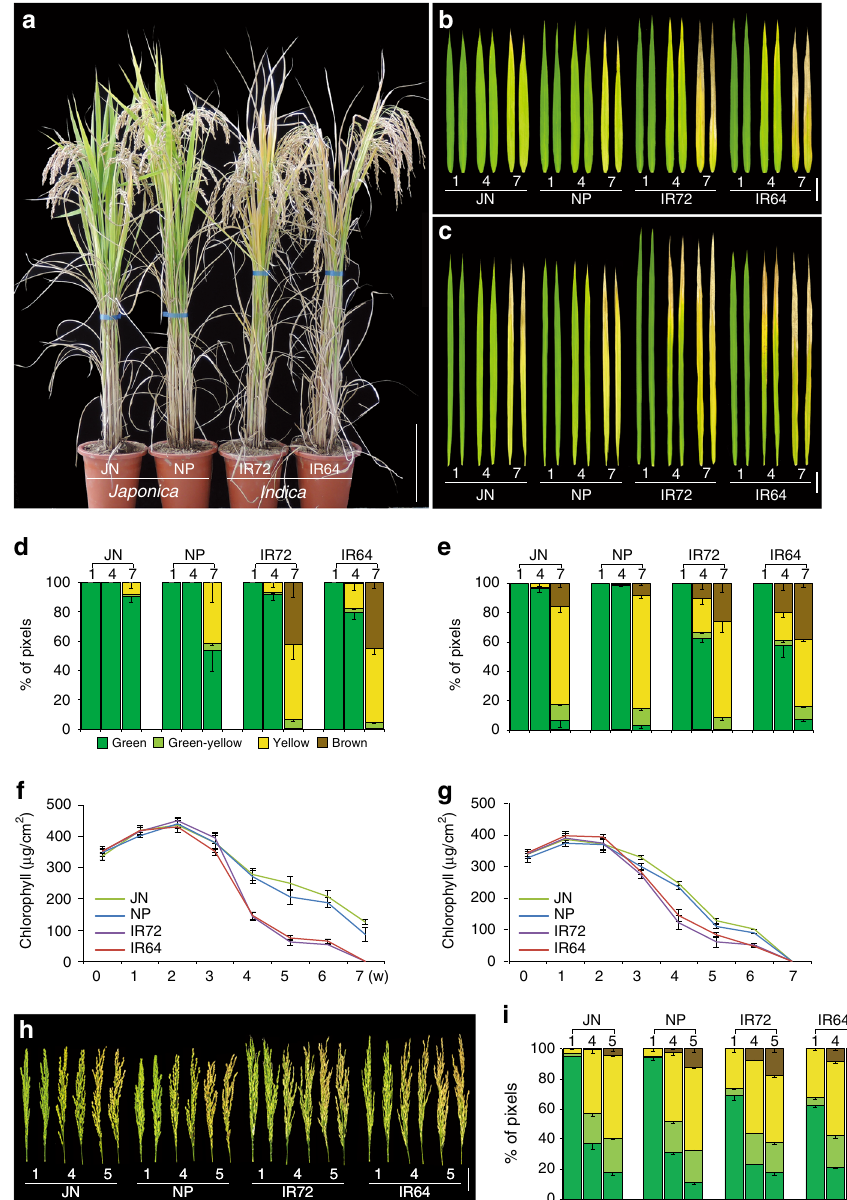
Fig. 1 Age-associated leaf senescence in japonica and indica- type rice plants. a Representative senescence phenotypes of two japonica (JN, Junam; NP, Nampyeong) and indica (IR72, IR64) type rice plants grown in natural fi eld conditions. Scale bar, 20 cm. Color changes of the fl ag ( b ) and second upper ( c ) leaves during seasonal senescence (1, 4, and 7 weeks after heading). Bars, 5 cm. Quanti fi cation of color changes of the fl ag ( d ) and second upper ( e ) leaves at 1, 4, and 7 weeks after heading by Automated Colourimetric Assay. The individual fl ag and second leaves were categorized into four groups according to their color: green, green-yellow, yellow, and brown. The percentage of each group is presented. Temporal changes of chlorophyll levels in the fl ag ( f ) and second upper ( g ) leaves from 0 to 7 weeks after heading. Color changes ( h ) and quanti fi cation of color ( i ) of panicles from 1, 4, and 5 weeks after heading. Data are means ± SE; n ≥ 3 independent samples. Source data of Fig. 1d – g and i are provided as a Source Data fi